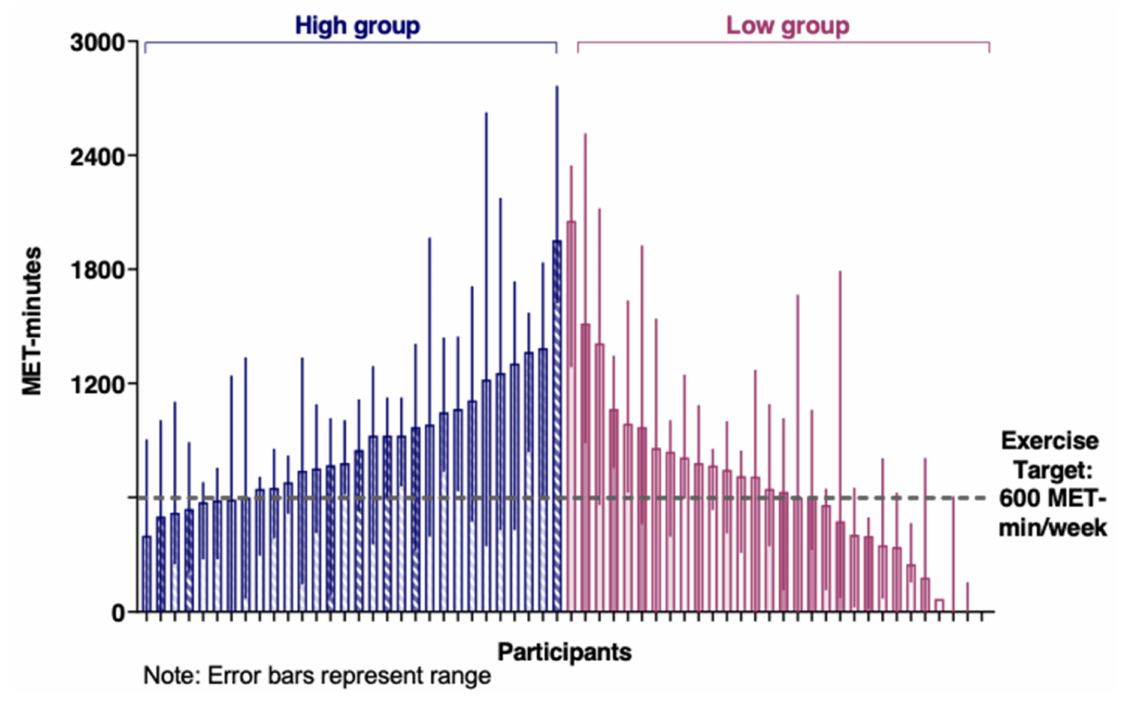
Figure 2. Median weekly exercise volume undertaken per participant in the high-supervision and low-supervision groups.